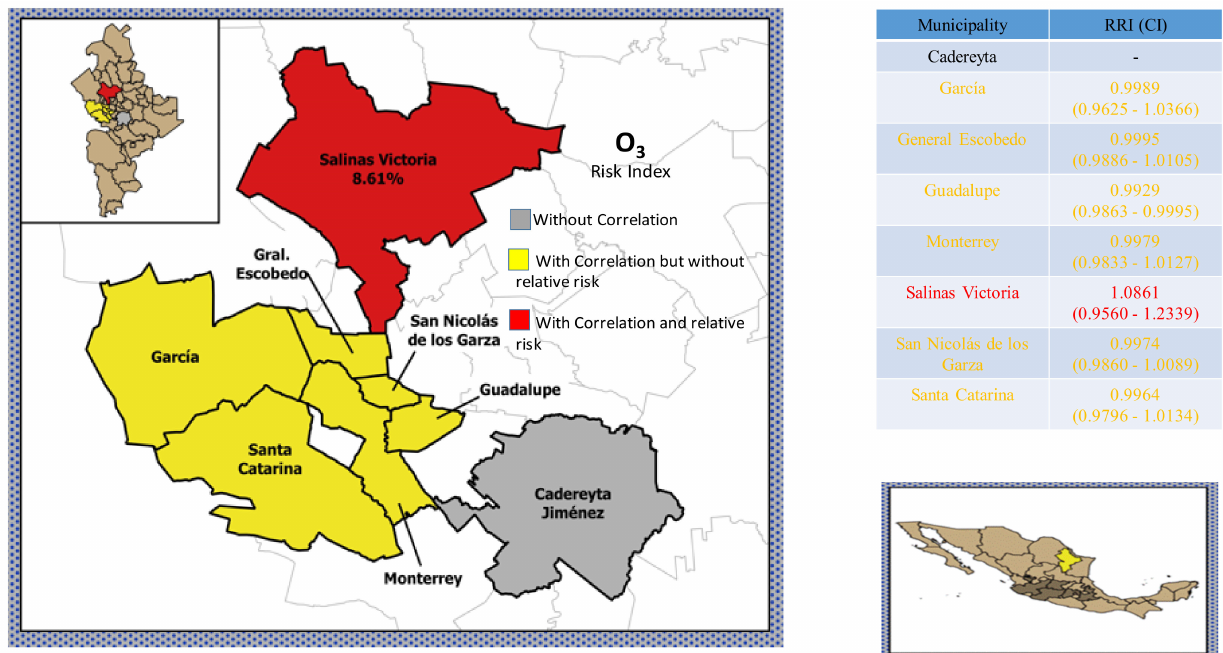
Figure 12. Relative risk indexes in MAM for the hypothetical scenario in which daily mean concentrations for O 3 increased by 10%, considering all